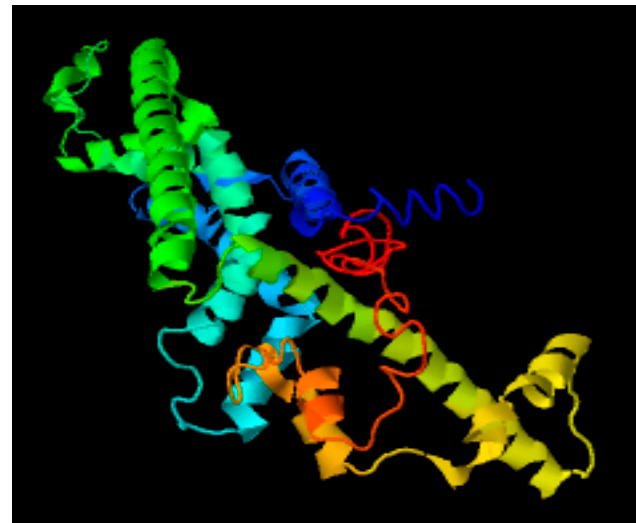
Figure 5. Best predicted model by MODELLER (6VAM A).